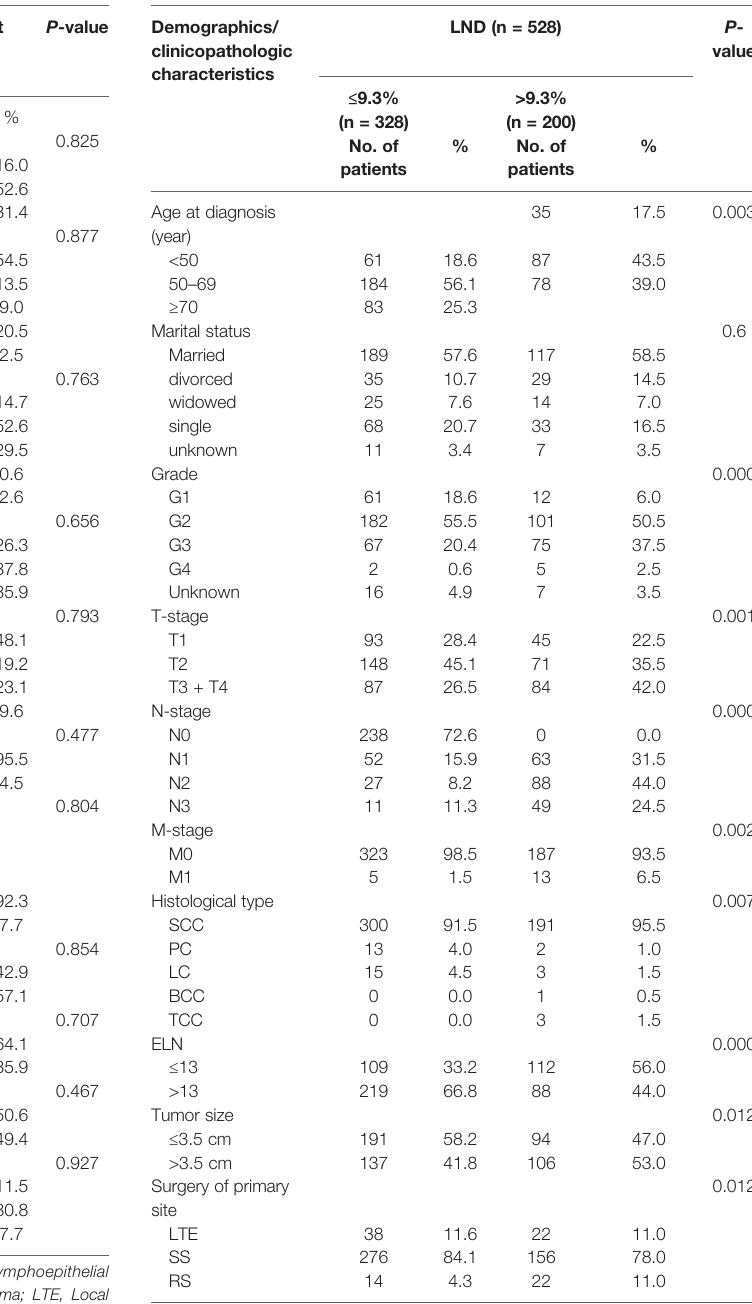
TABLE 2 | Relationship between LND and demographics/clinicopathologic